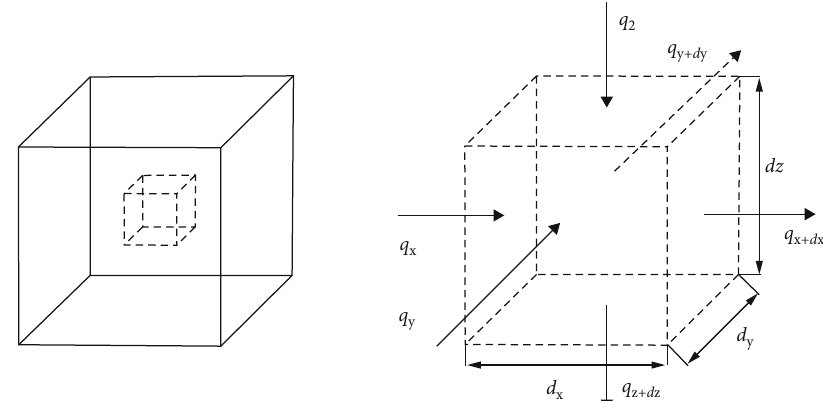
Figure 4: The energy fl ow of the microelement.